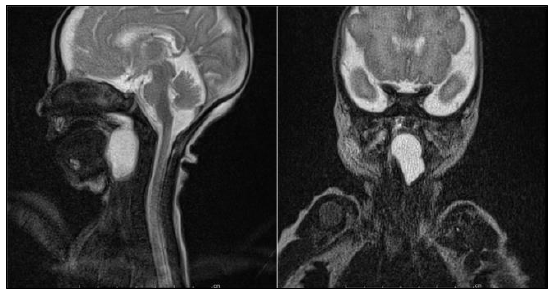
Figure 1: Magnetic resonance images demonstrating the vallecular cyst